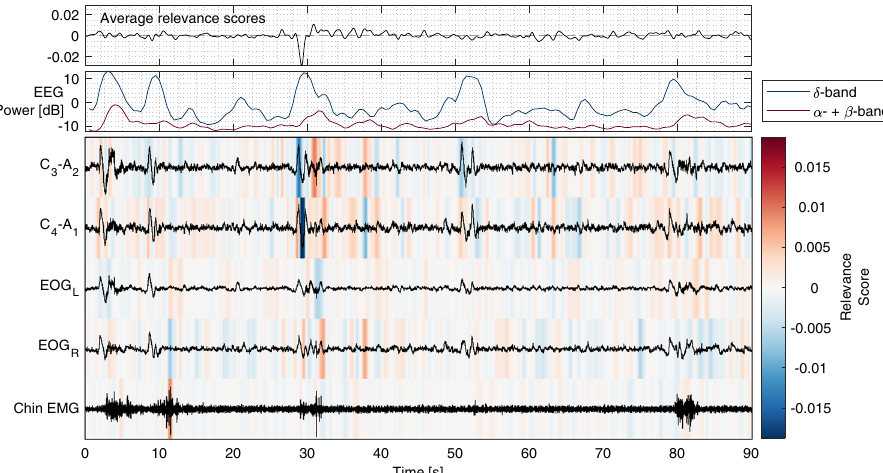
Fig. 2 Example of model (b; EEG + EOG + EMG) interpretation through relevance attribution of samples. The top plot shows relevance scores averaged across channels (C3-A2, C3-A1, EOGL, EOGR, Chin EMG). The second plot shows EEG power in the δ -band (0 – 4 Hz) and the combined α - and β -bands (>8 Hz). Red and blue indicate positive and negative attribution to the age estimate, respectively. Relevance attribution was computed using gradient SHAP.